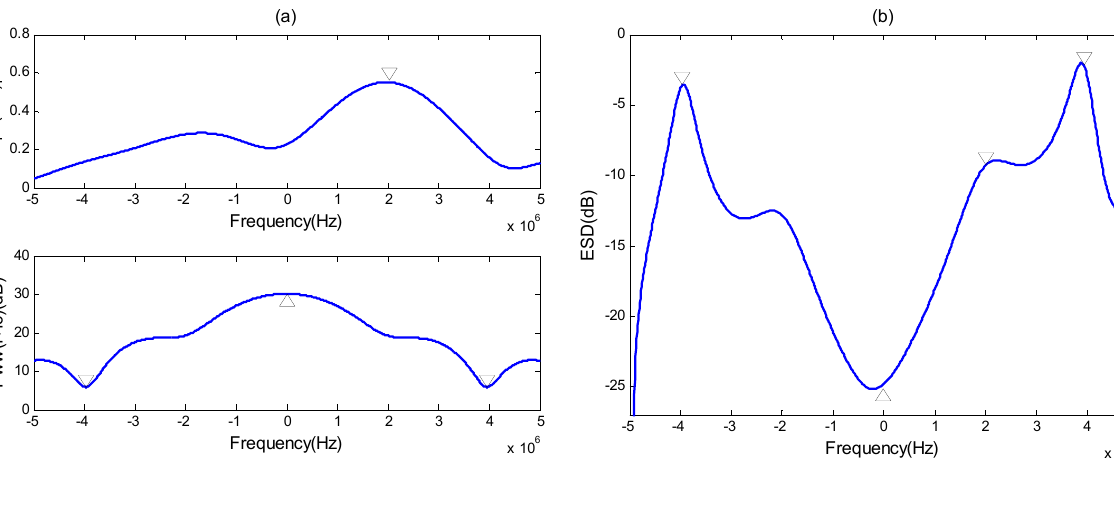
Figure 2. (a) Amplitude spectrum of an extended target impulse response and clutter random channel PSD; (b) Optimal ESD of the transmit